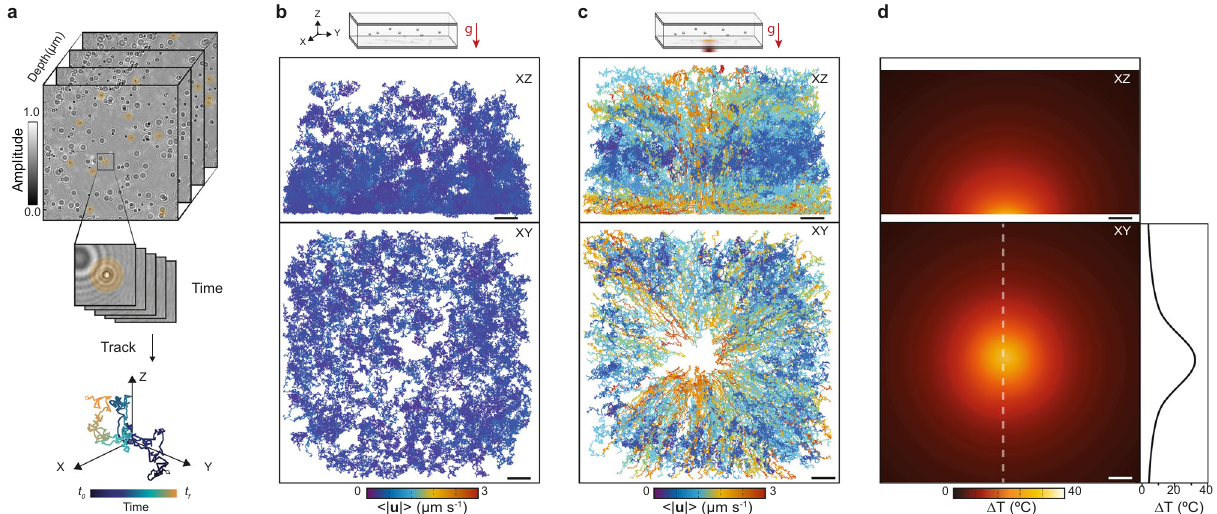
Fig. 2 Correlative 3D single-particle tracking and label-free thermometry. a Representative 3D trajectory obtained from a numerically propagated depth- stack of intensity images. b , c Schematic depicting the orientation of the opto fl uidic platform with respect to gravity, and spatial distribution map in the XZ (top) and XY (bottom) planes of the trajectories of each tracer particle under thermal equilibrium and non-equilibrium conditions, respectively. Each track is assigned a color according to the average magnitude of the instantaneous velocity. d Experimentally measured 3D steady-state temperature distribution due to plasmon heating in the XZ (top) and XY (bottom) planes beside a cross-section along the dashed line, which led to the particle dynamics measured in ( c ). Scale bars: 10 µ